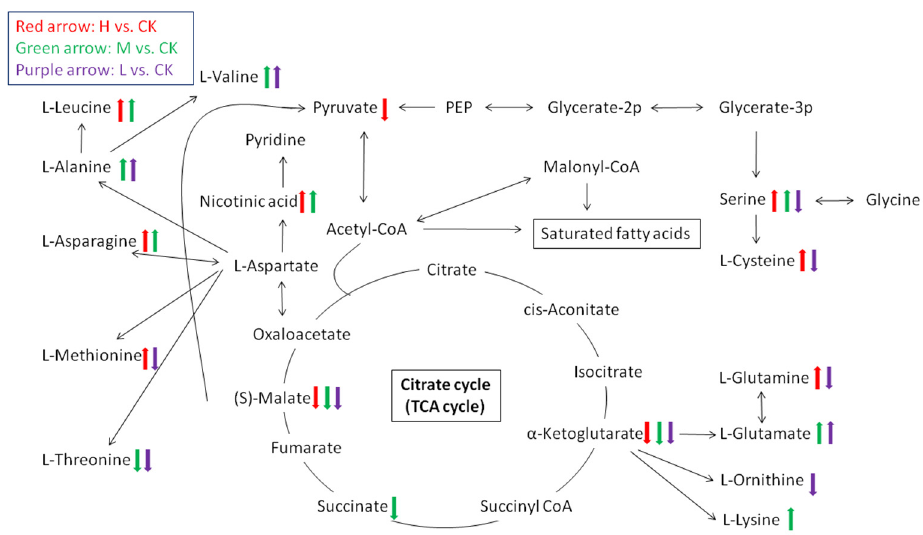
Figure 8. Schematic overview of the main impacted metabolites and major metabolic pathways related to energy and amino acid metabolism in Arabidopsis thaliana . Upward arrows represent upregulation, and downward arrows represent downregulation. Three colors of arrows represent three treatments of Eupatorium adenophorum aqueous extracts.